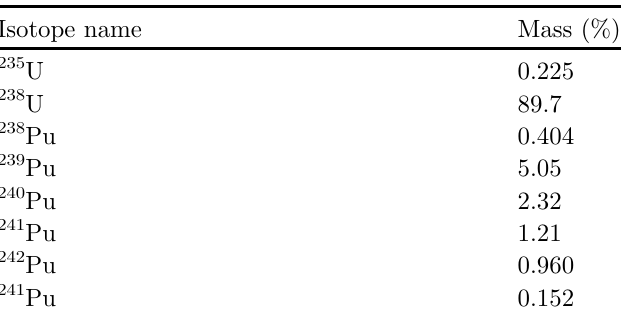
Table 1. Heavy metal composition of a typical mixed